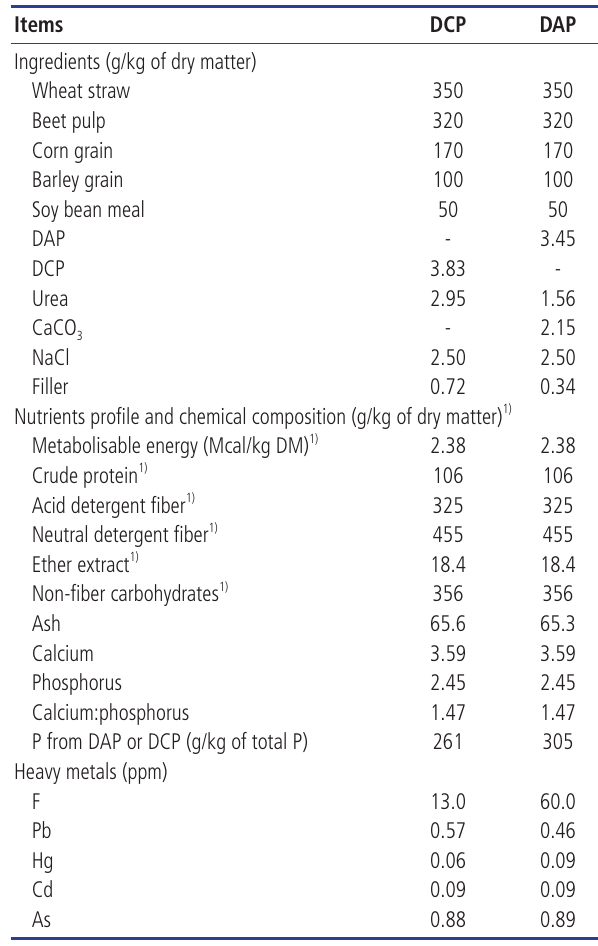
Table 2. Ingredients and chemical composition of experimental diets fed to finishing lambs